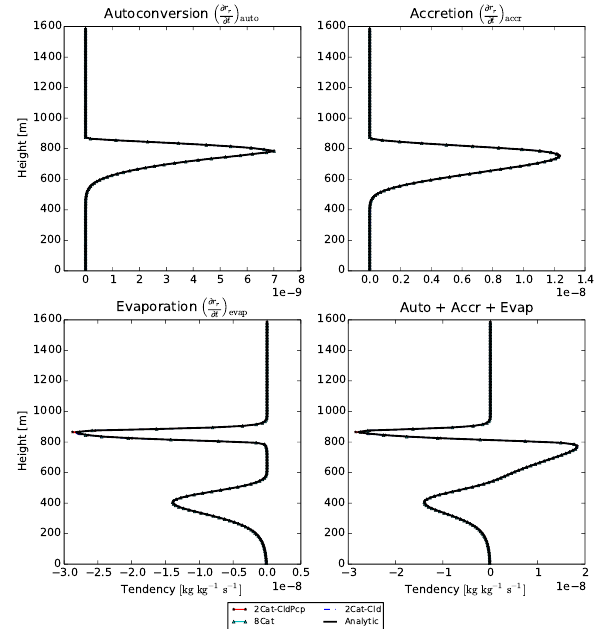
Figure 7. DYCOMS-II RF02: mean profile plots of the four ten- dencies. The simulations in these plots use 32 sample points. For each configuration, an ensemble of 12 simulations is used, each with a different seed. Profiles are averaged over all 360 timesteps of the simulation and all 12 ensemble members. It is seen that all SILHS sampling methods are clearly convergent at all height levels. All of the lines overlap well, indicating that all three processes are sampled well by all three sampling